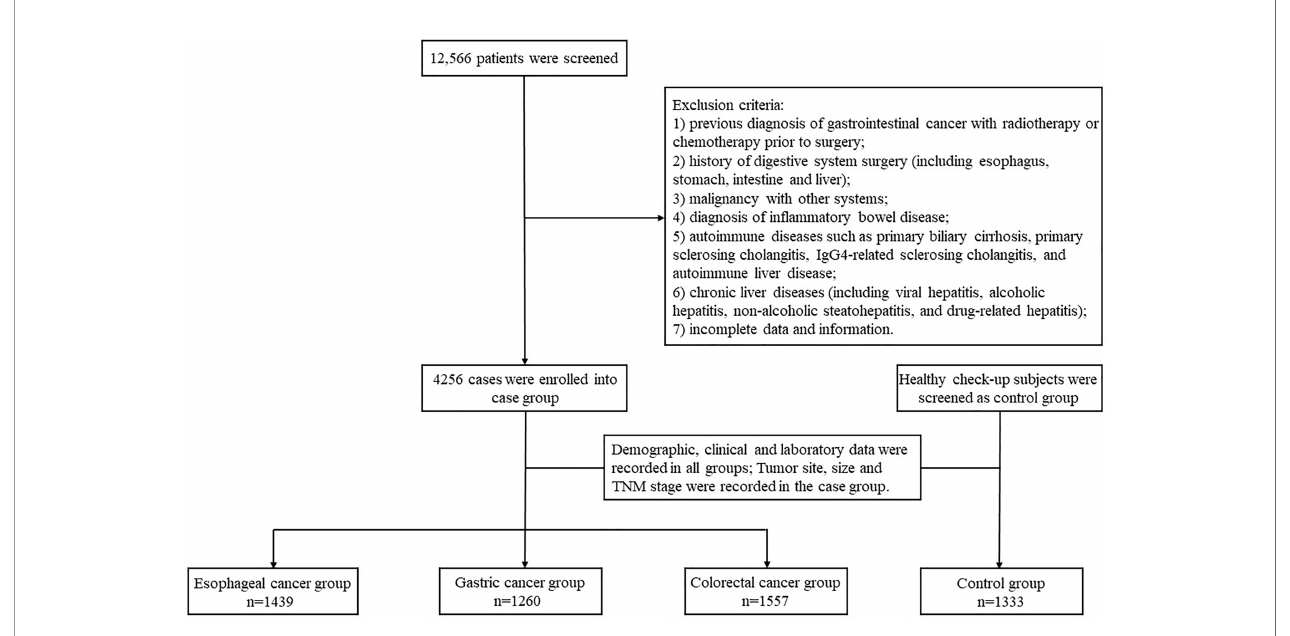
FIGURE 1 | Flow chart of participant